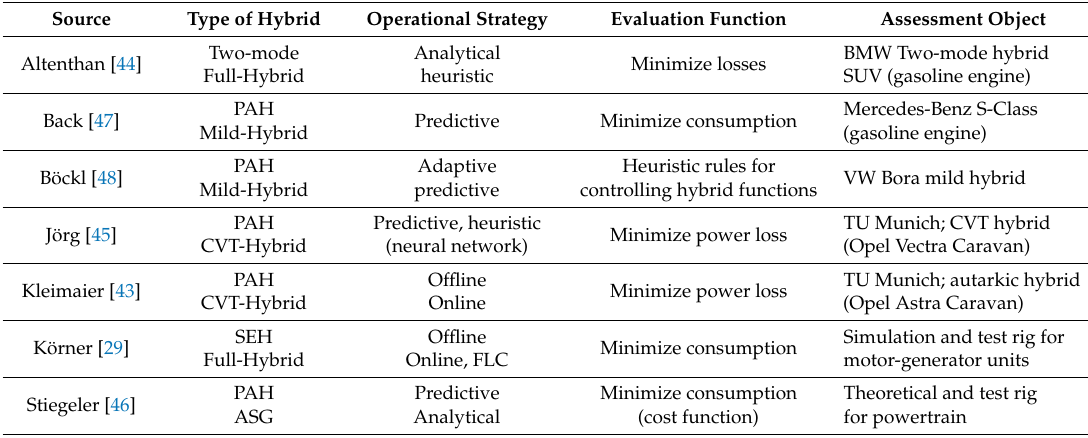
Table 9. Overview of studies related to the development of operational